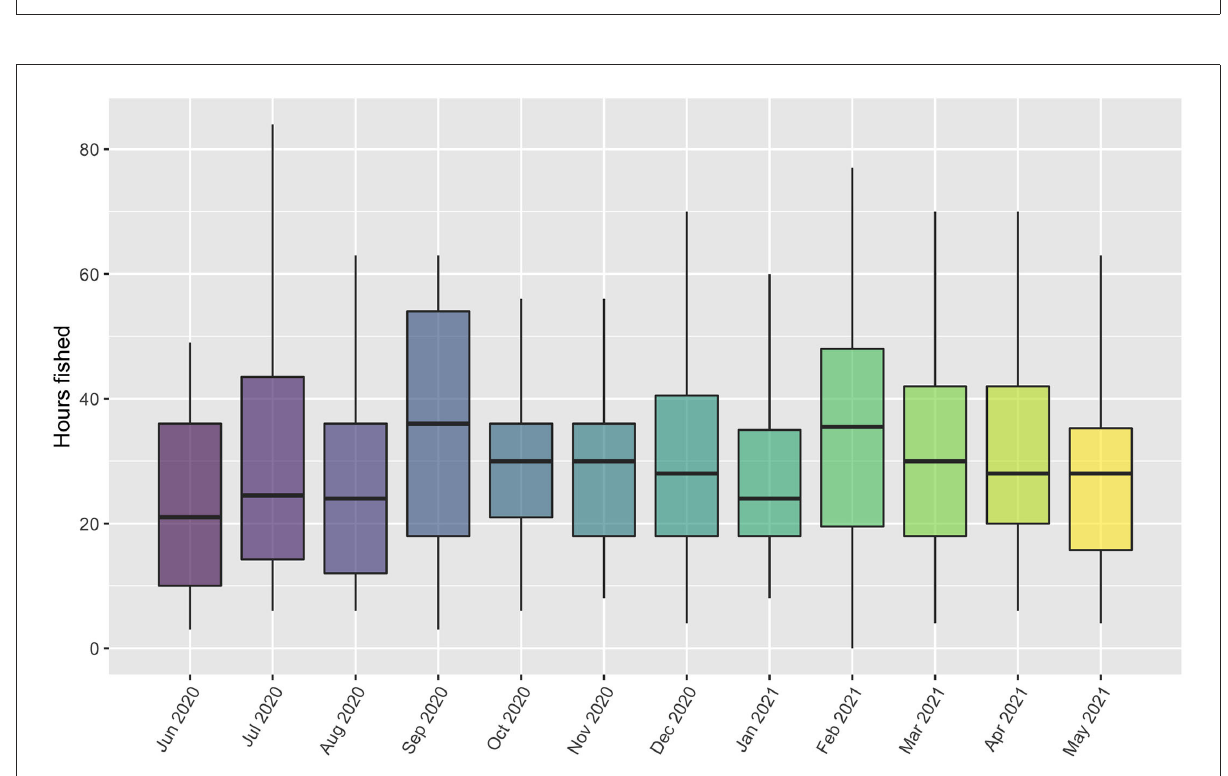
FIGURE5 Total hours fished in previous week (among those who